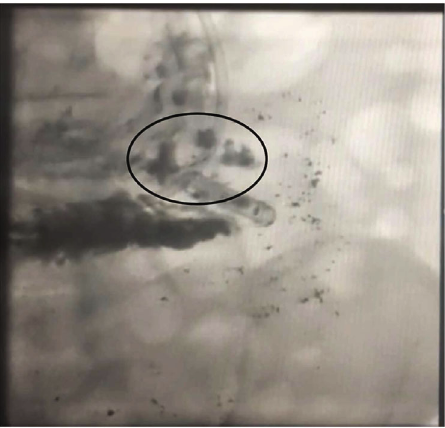
Figure 3: Fluoroscopy images at the time of endomyocardial biopsy posttransplant biopsy demonstrating residual medications at the distal end of the esophagus